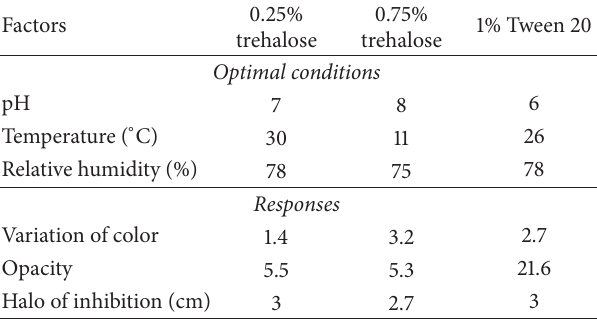
Table 2: Optimal conditions for the function of desirability and optimal responses for the 14 days of